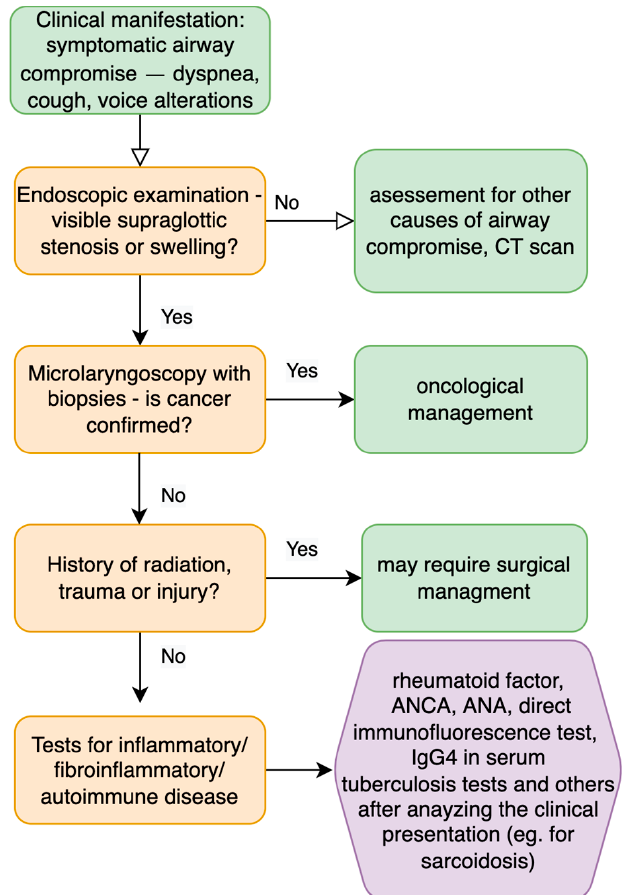
Figure 5. Diagnostic steps for patients with supraglottic stenosis and compromised symptomatic airway